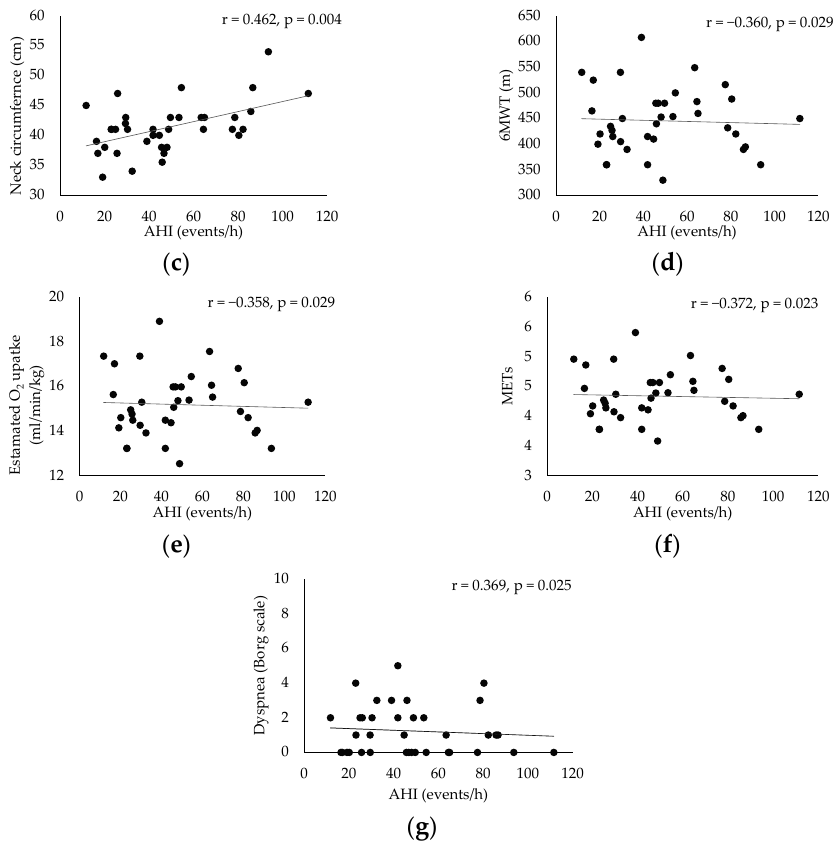
r = 0.360, p = 0.029